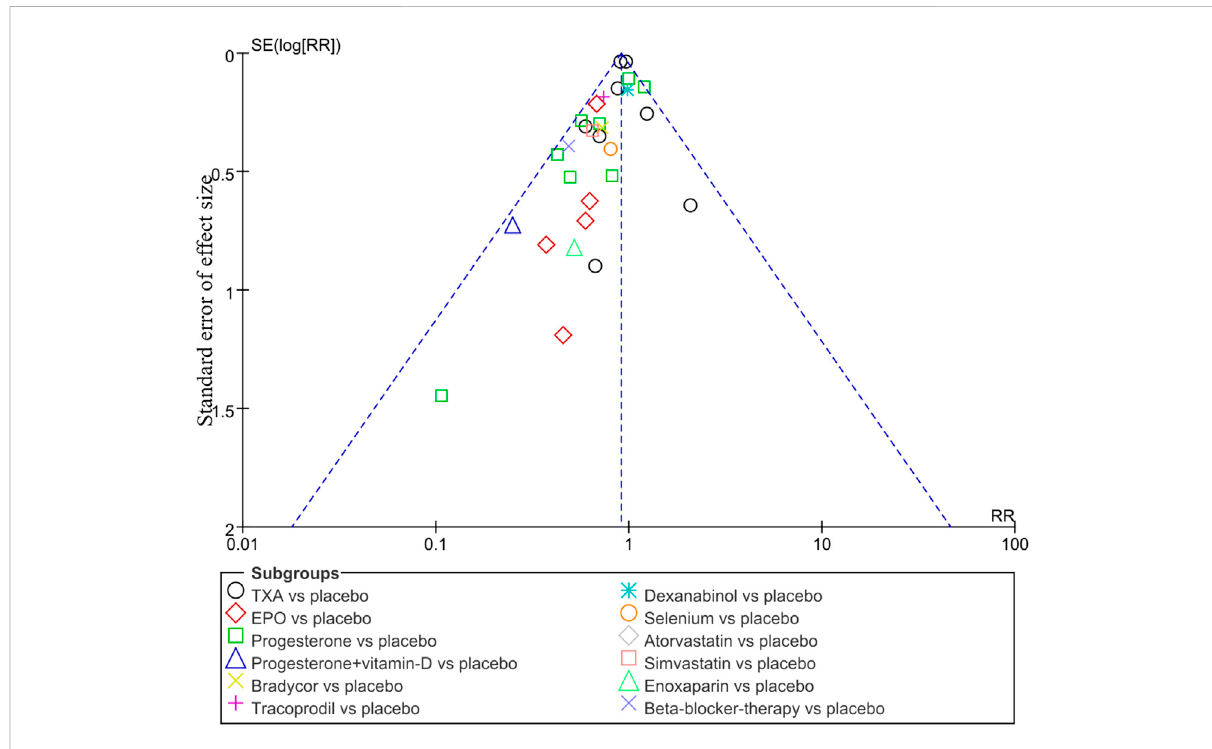
FIGURE 3 Funnel plots for the detection of publication bias on the mortality of